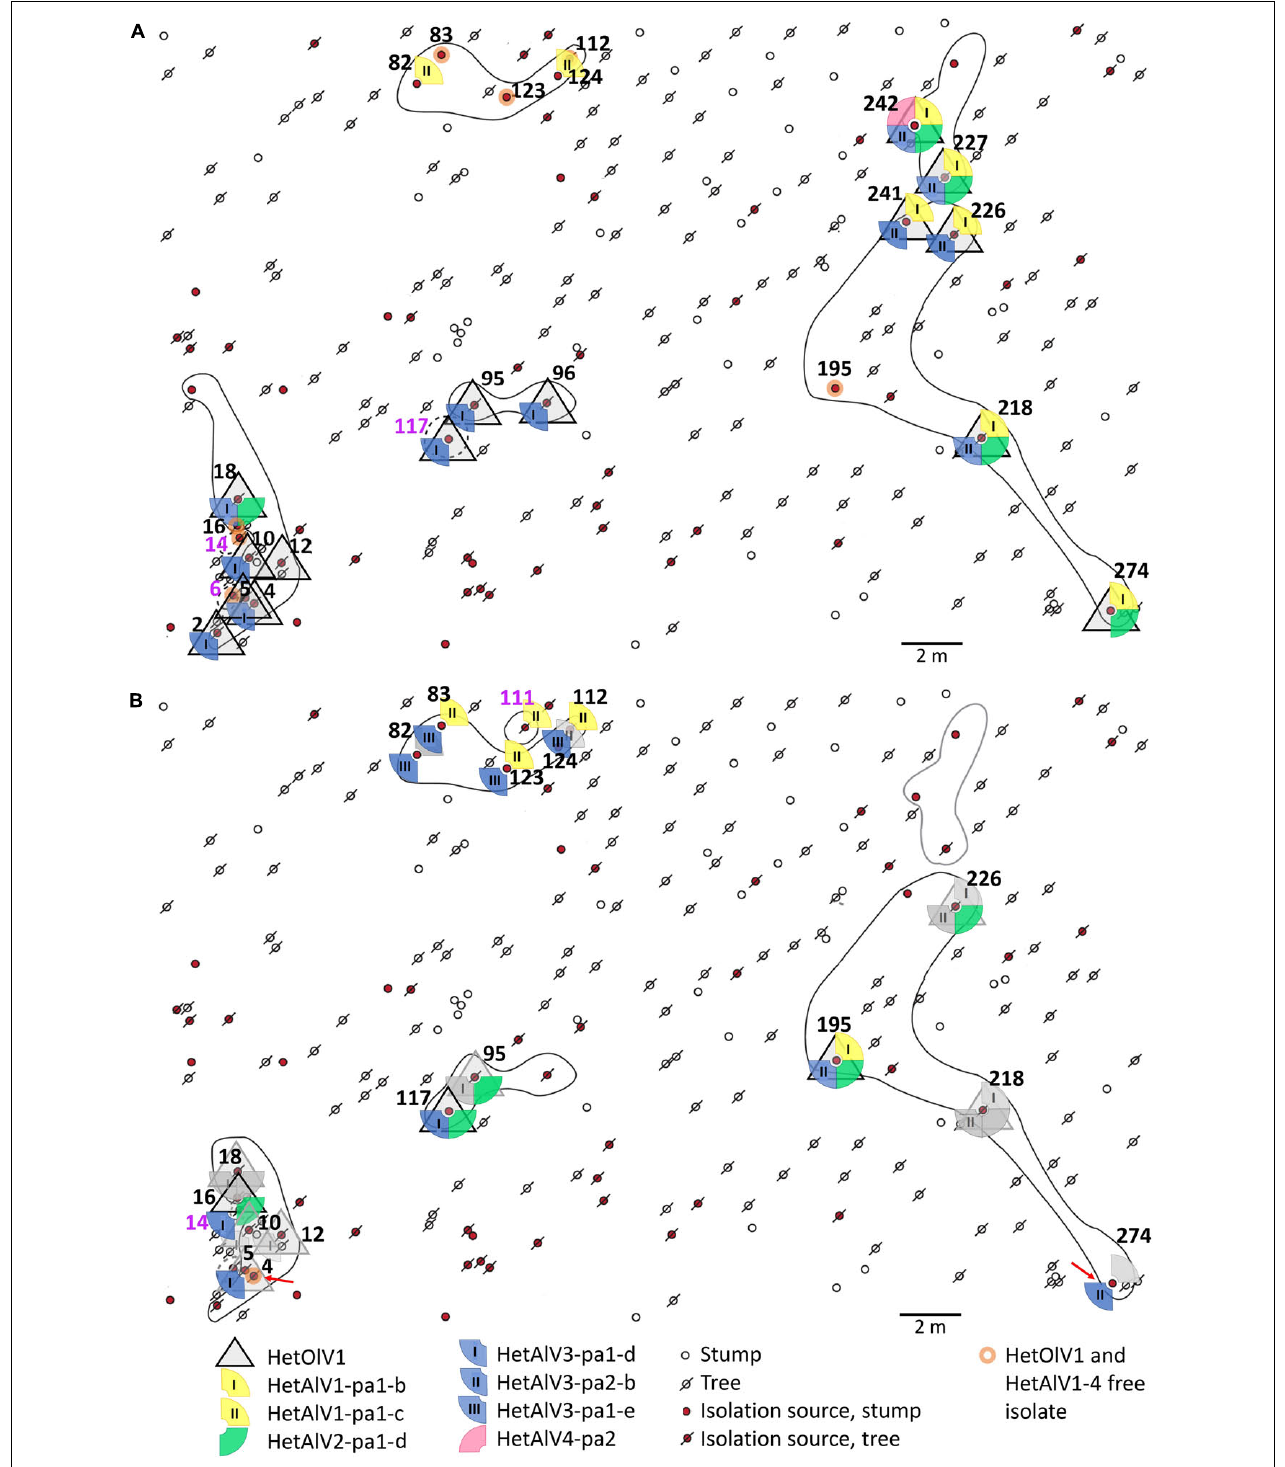
FIGURE 1 | Spatial distribution of Heterobasidion ourmia-like virus 1 (HetOlV1), Heterobasidion ambi-like viruses 1–4 (HetAlV1–4), and H. parviporum isolates in 2005 (A) and 2012 (B) . The isolation sources refer to individual stumps and trees with H. parviporum infection 2005 and resampled 2012. The sampling points of H. parviporum isolation sources included in the analyses are indicated with numbers (black font = clone includes more than single isolate; purple = clone includes only one isolate) and clones marked with circles (solid line = heterokaryon; dashed line = homokaryon; black line = viable clone; gray line = clone not found in 2012). Red arrows indicate viral losses. Symbols in gray ( B , 2012 situation) indicate that the virus content remained the same as in 2005, and colorful symbols indicate virus gains in the isolation source.